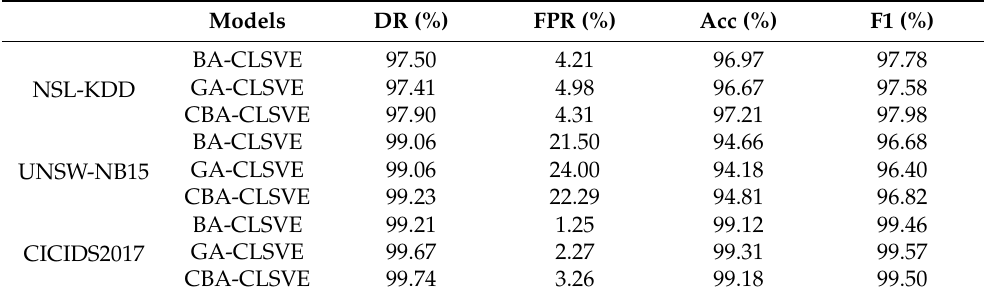
Table 11. Performance comparisons of the Class-Level Soft-Voting Ensemble (CLSVE) with feature selection based on different Optimization Algorithms on the three datasets.